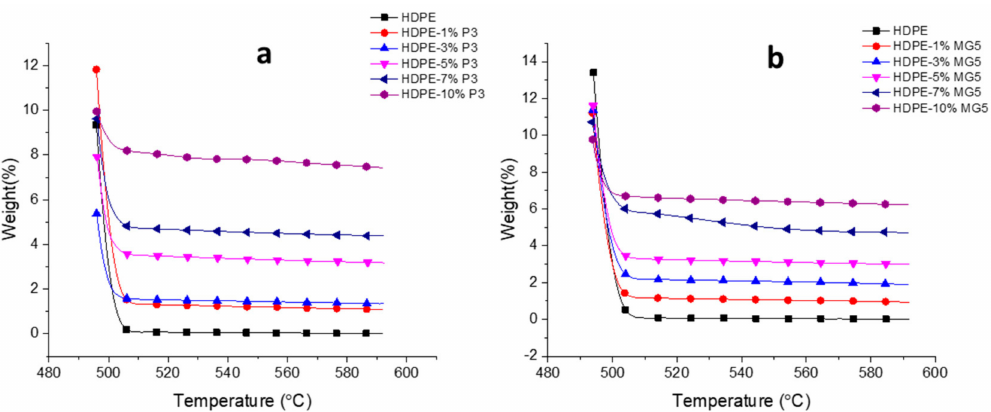
Figure 9. TGAs curves of ( a ) HDPE-P3 and ( b ) HDPE-MG5